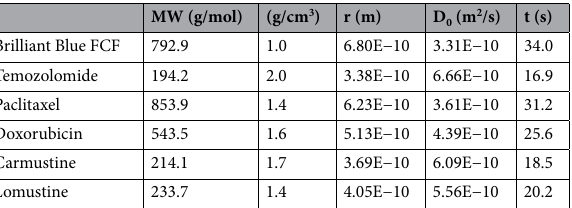
Table 1. The diffusion coefficients and time required for diffusion of particles of varying sizes calculated using their respective molecular weights and